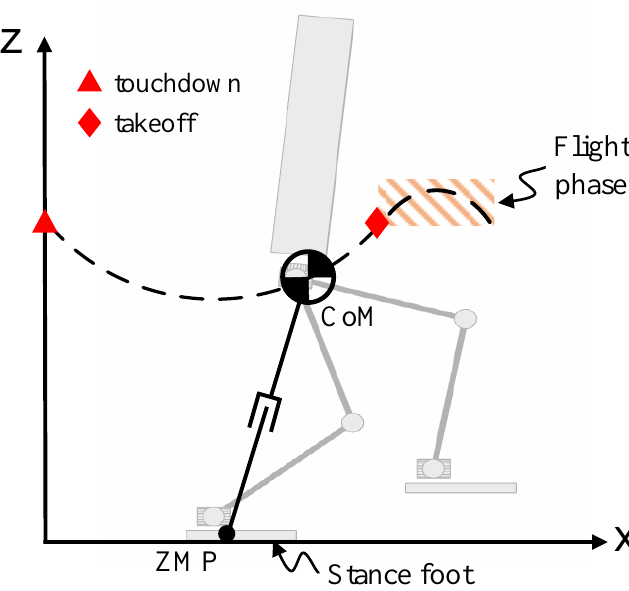
Figure 1. Variable-height inverted-pendulum (VHIP)